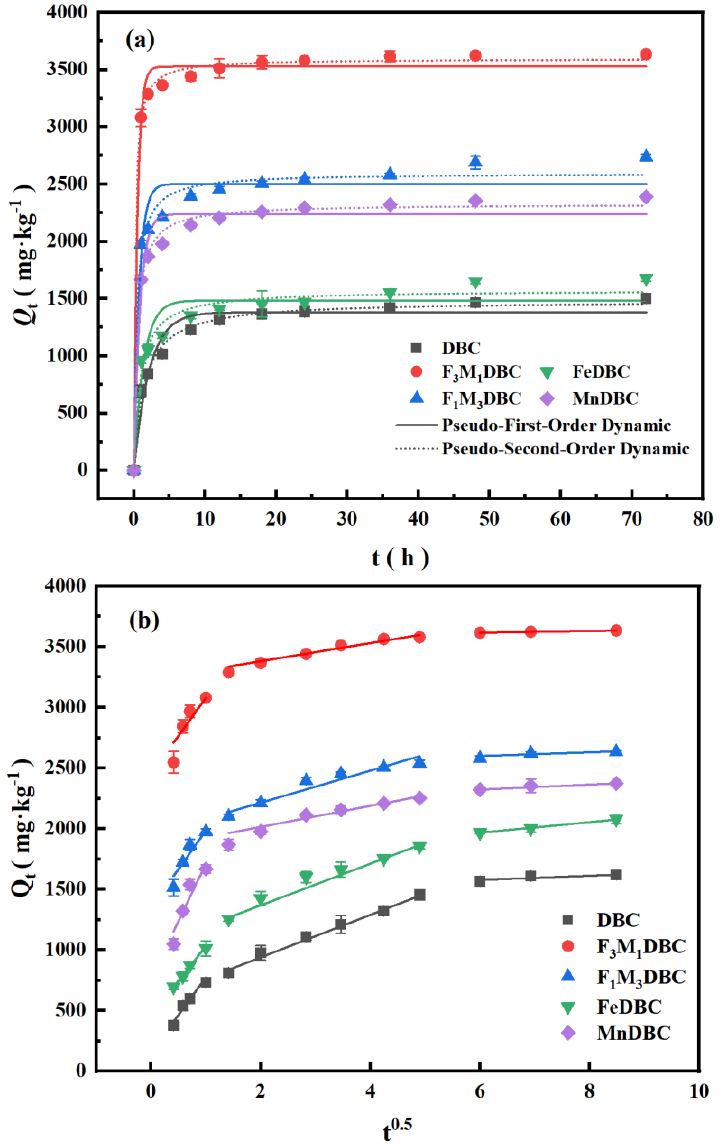
Figure 3. The atrazine adsorption kinetics of original biochar and Fe-Mn modified biochar.